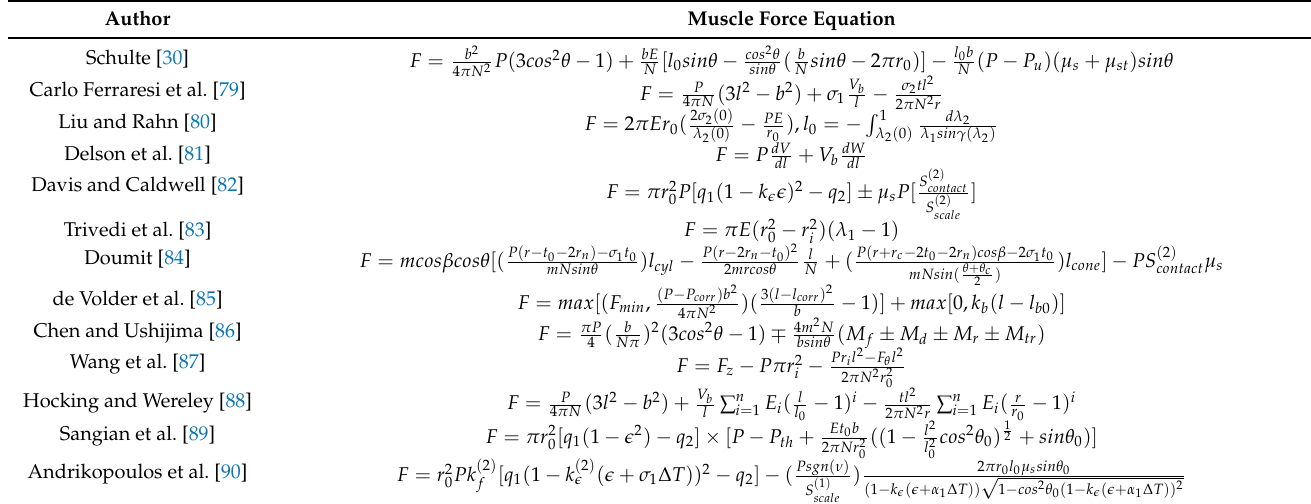
Table 2. Muscle force equations of considered for various models of